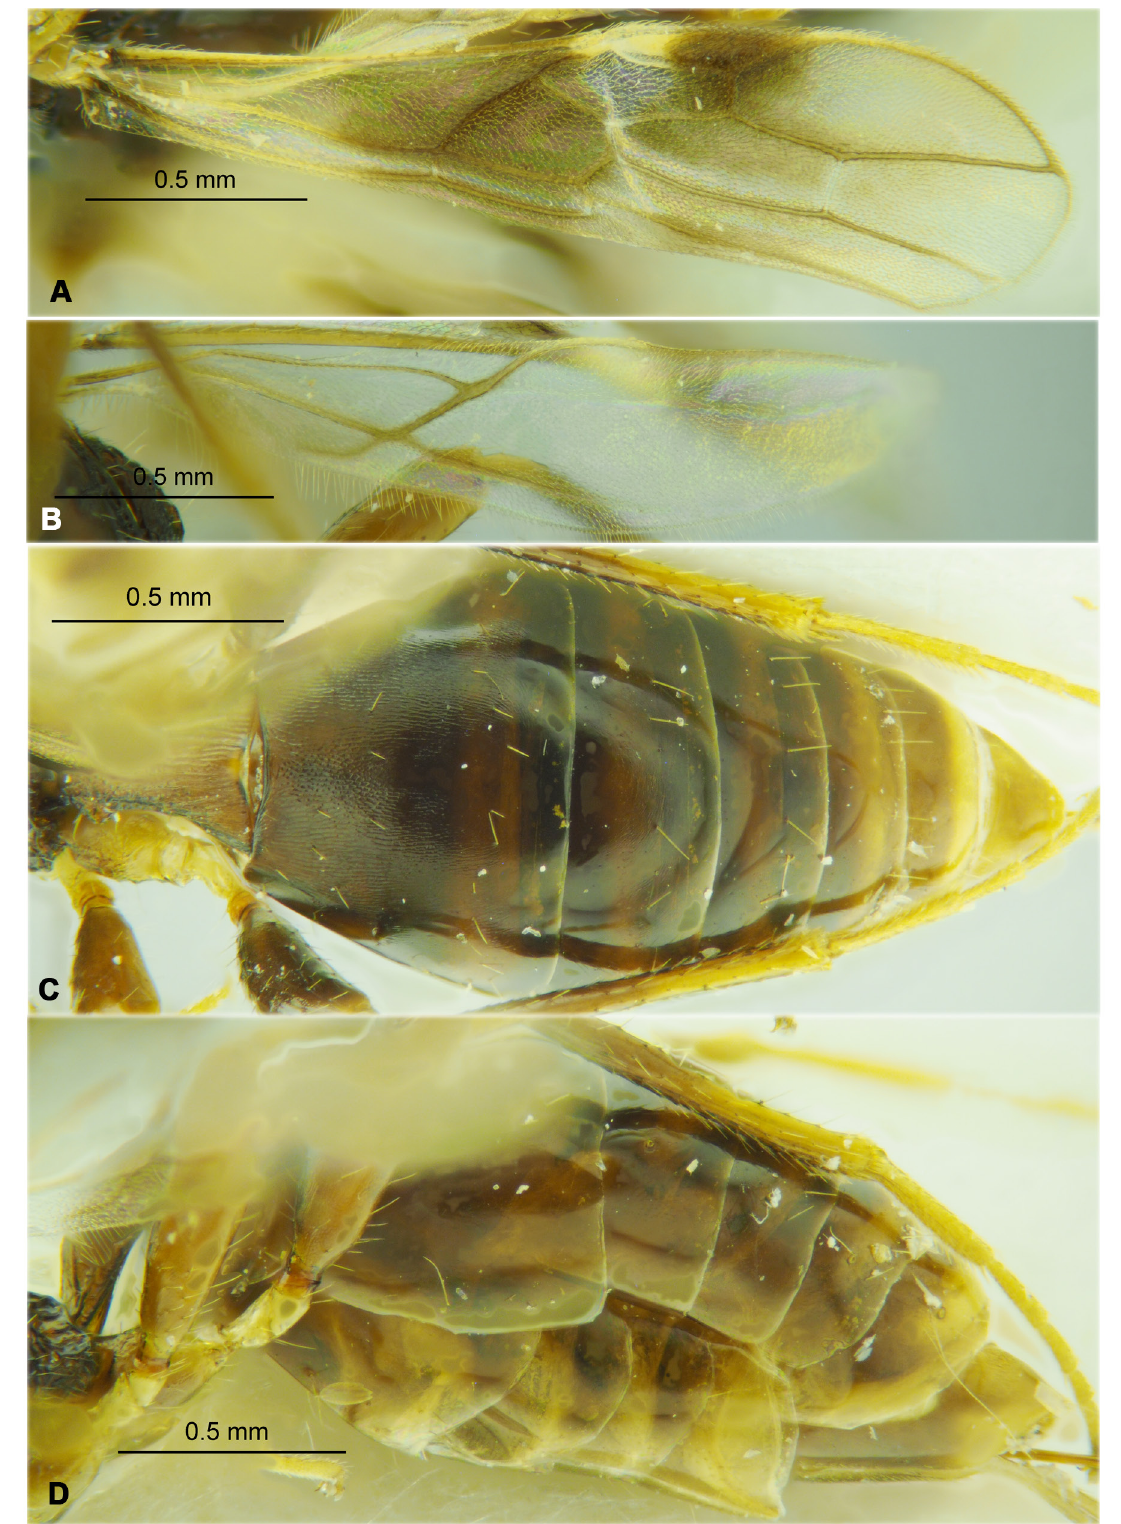
Fig. 17. Spathius alkadanus Belokobylskij sp. nov., holotype, ♀ (RMNH). A . Fore wing. B . Hind wing. C . Metasoma, dorsal view. D . Metasoma, lateral